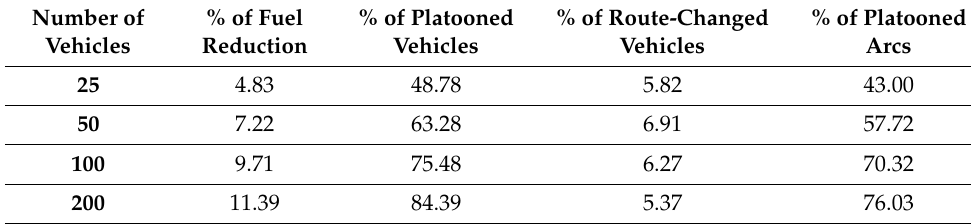
Table 8. Performance for different numbers of vehicles.